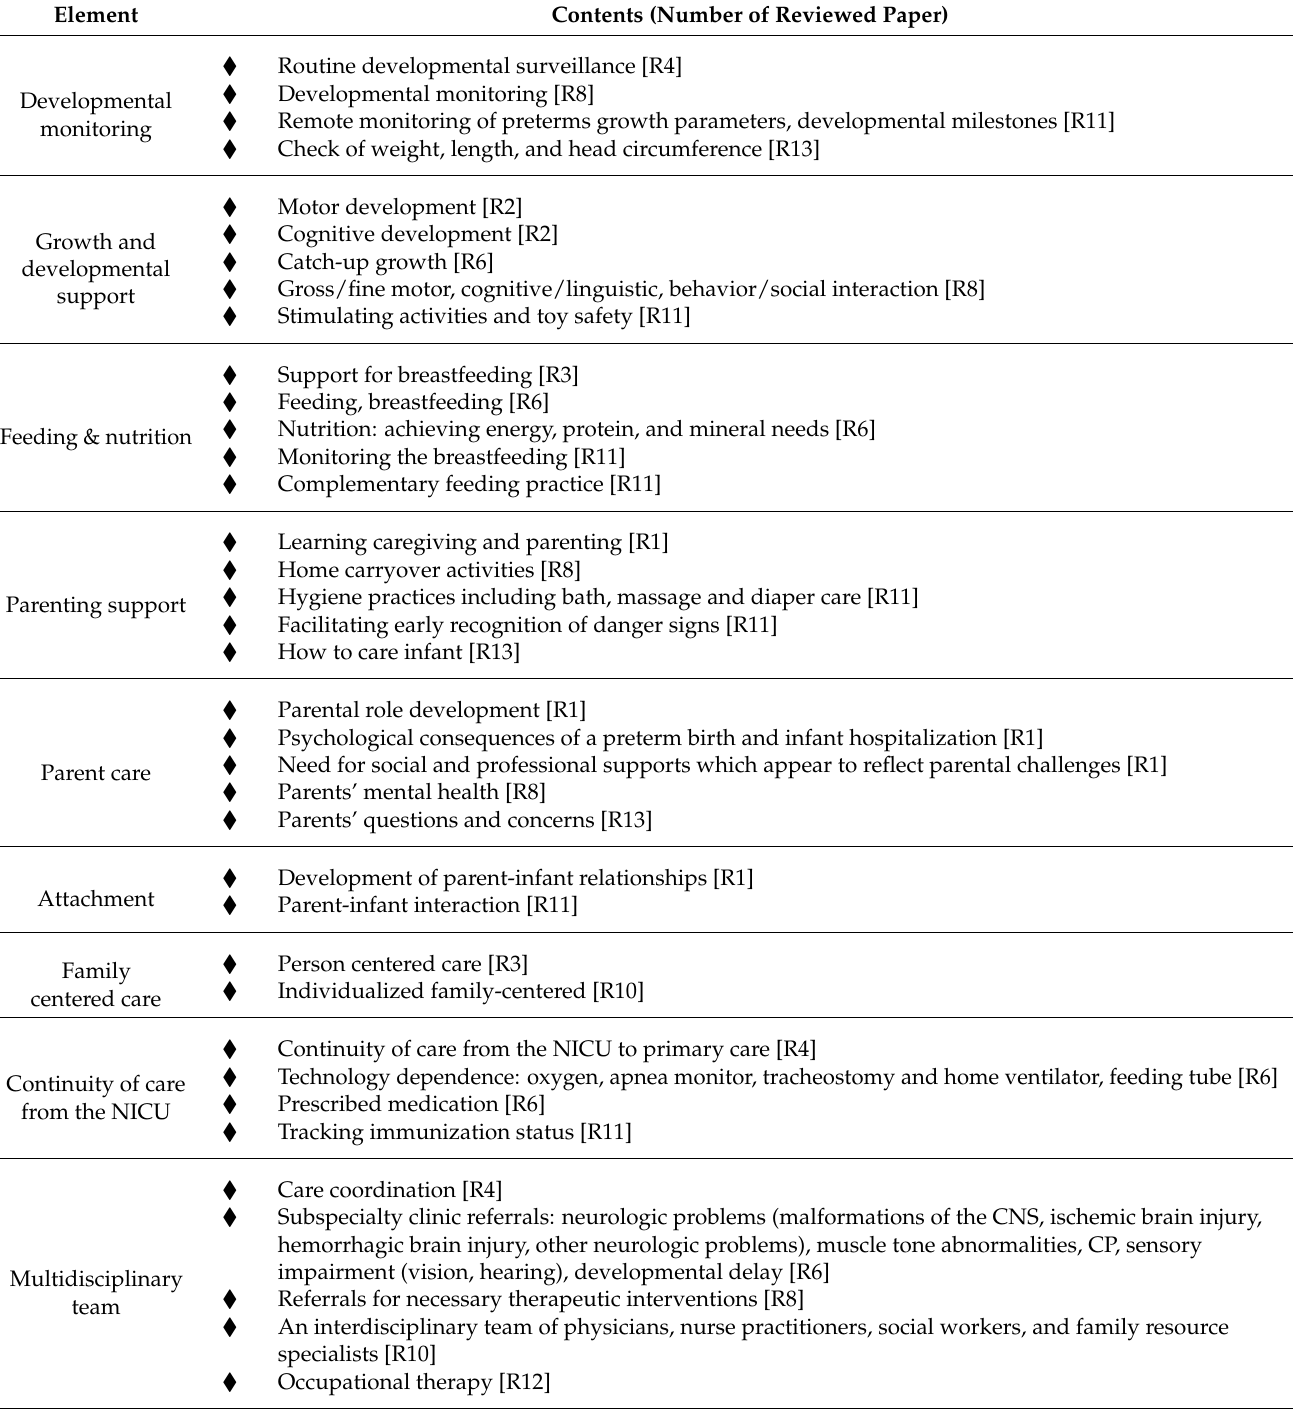
Table 2. Elements of follow-up care after neonatal intensive care unit (NICU)